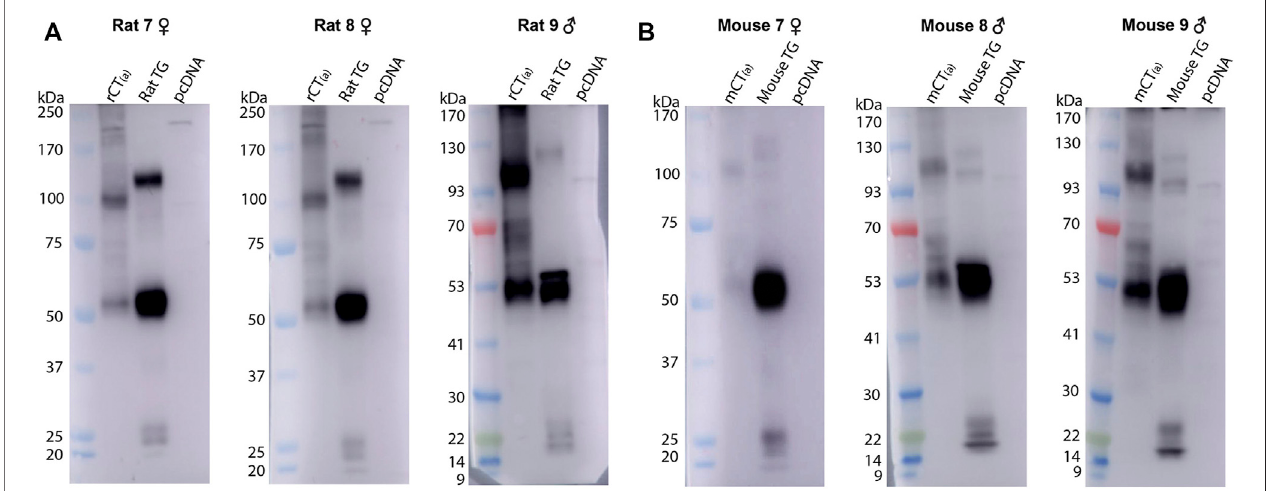
FIGURE 5 | CTR-like immunoreactivity in rat and mouse TG lysate using immunoblotting with mAb8B9. (A) Immunoblots using lysate preparations from adult rat TG (20 µg) and HEK293S cells (10 µg) transfected with rat CT (a) or vector alone (pcDNA). (B) Immunoblots using lysate preparations from adult mouse TG (20 µg) and HEK293S cells (10 µg) transfected with mouse CT (a) or vector alone. Blots were probed with mAb8B9 (2 µg/ml). MW markers are shown on the left of each blot, with apparent MW in kDa. This image shows western blots of samples from individual mouse or rat TG. Images were adjusted uniformly for brightness and contrast for presentation